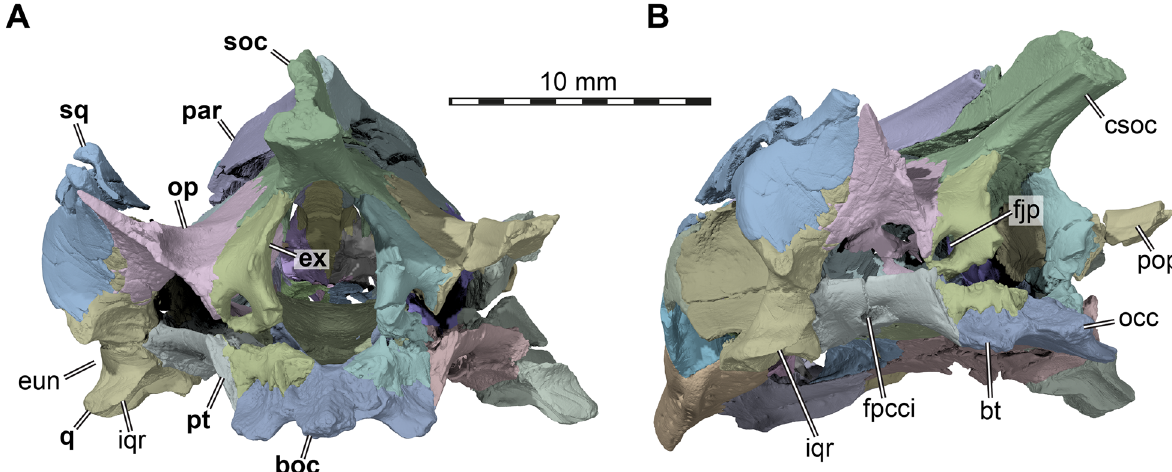
Fig. 8 Three dimensional renderings of the posterior of the cranium of Plastomenus thomasii (AMNH FR 6015). A posterior view; B left posterolateral and slight ventral view. Note that bones are labelled in bold. boc basioccipital, bt basi tuber, csoc crista supraoccipitalis, eun Eustachian notch, ex exoccipital, fjp foramen jugulare posterius, fpcci foramen posterius canalis carotici interni, iqr infolding quadrate ridge, occ occipital condyle, op opisthotic, par parietal, pop paroccipital process, pt pterygoid, q quadrate, soc ssupraoccipital, sq